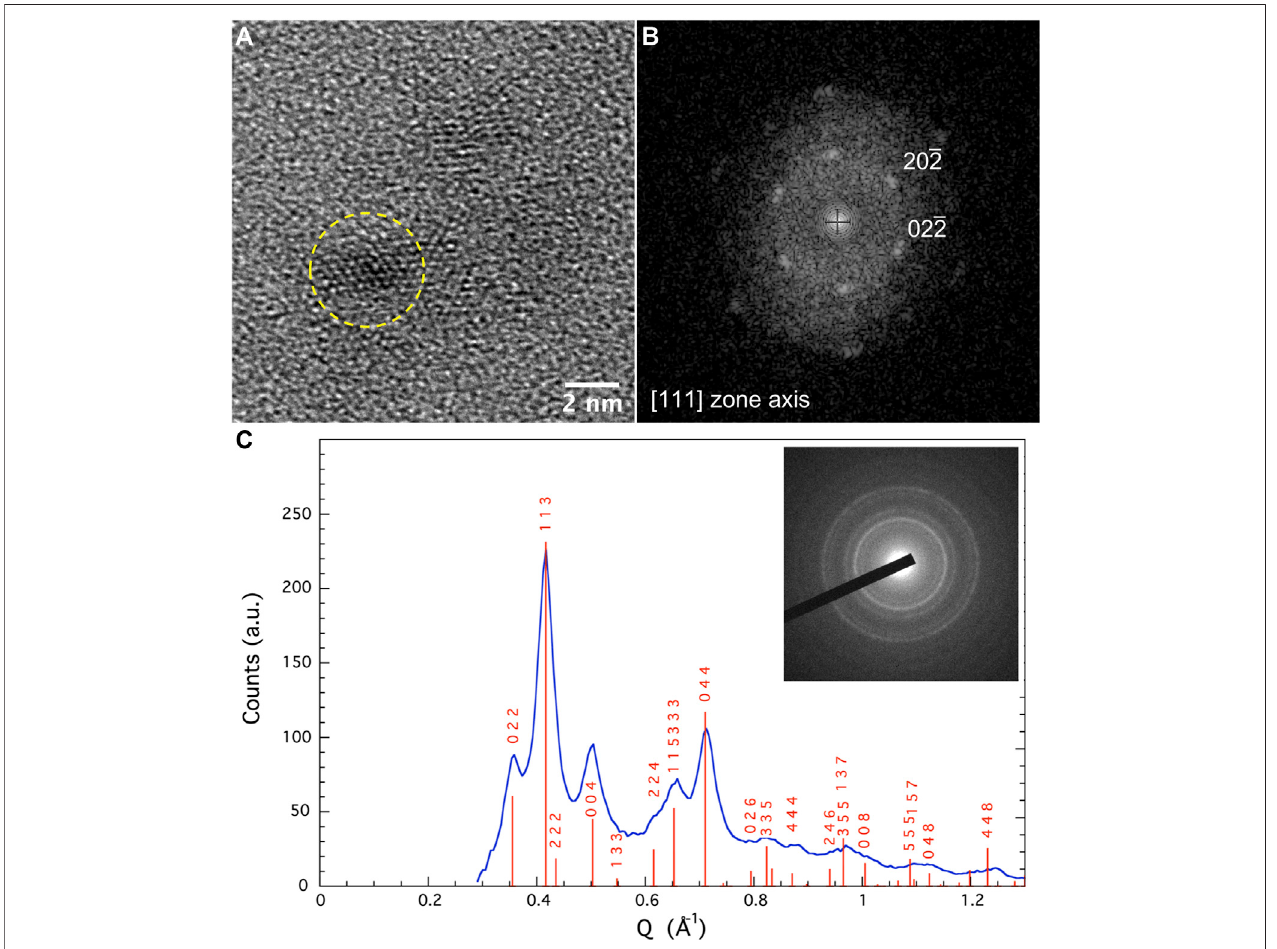
FIGURE 2 | (A) TEM-BF images of ferrite nanoparticles; (B) the fast Fourier transform (FFT) pattern recorded on a representative one fully indexed within the NiFe 2 O 4 structure along [111] zone axis; (C) selected area electron diffraction (SAED) pattern related to the same observed region. The recorded diffraction rings match very well with the spinel